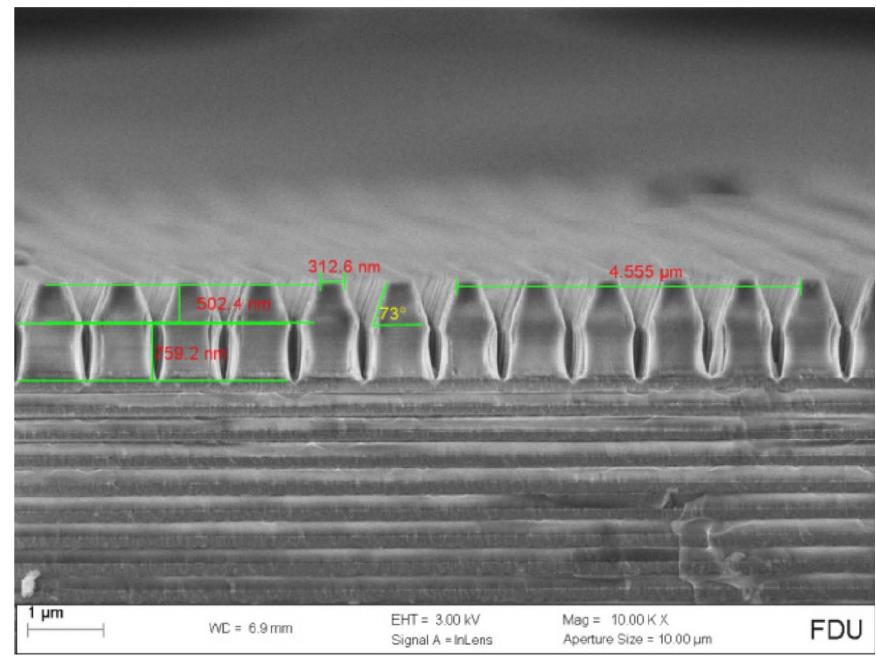
Figure 21. SEM image of the as ‐ prepared grating.